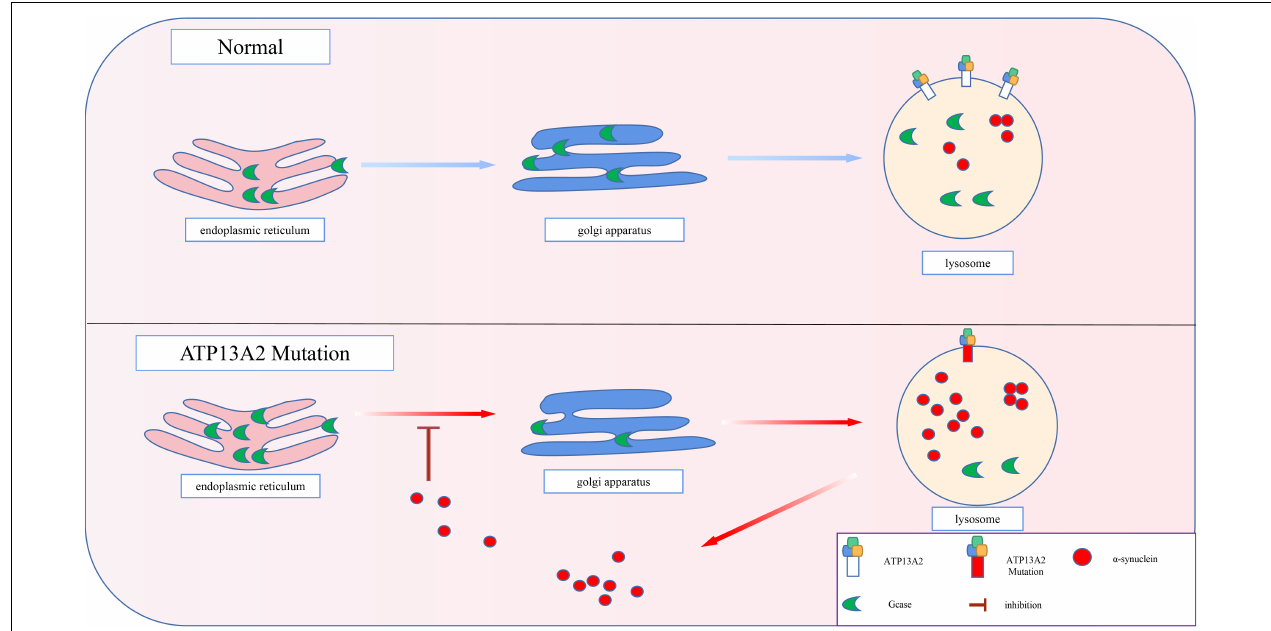
FIGURE 4 | Progressive accumulation of α -synuclein. The transport of GCase is impaired by pathological accumulation of α -synuclein. Thus, GCase remains in the endoplasmic reticulum and cannot reach the lysosome to exert its normal function, which accelerates the pathological accumulation of α